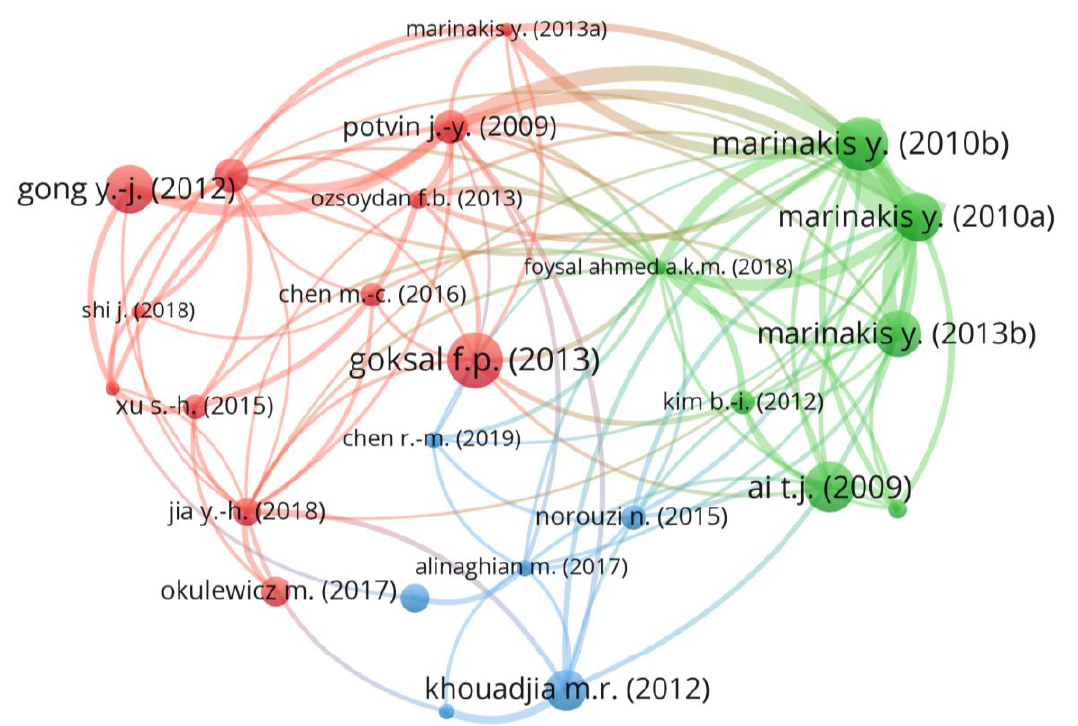
Figure 10. Bibliographic coupling documents network for the Scopus database search, 10 minimum citations [21–38]. Table 6. Key PSO/VRP documents from the Scopus query that are bibliographically coupled, n = 25/263.